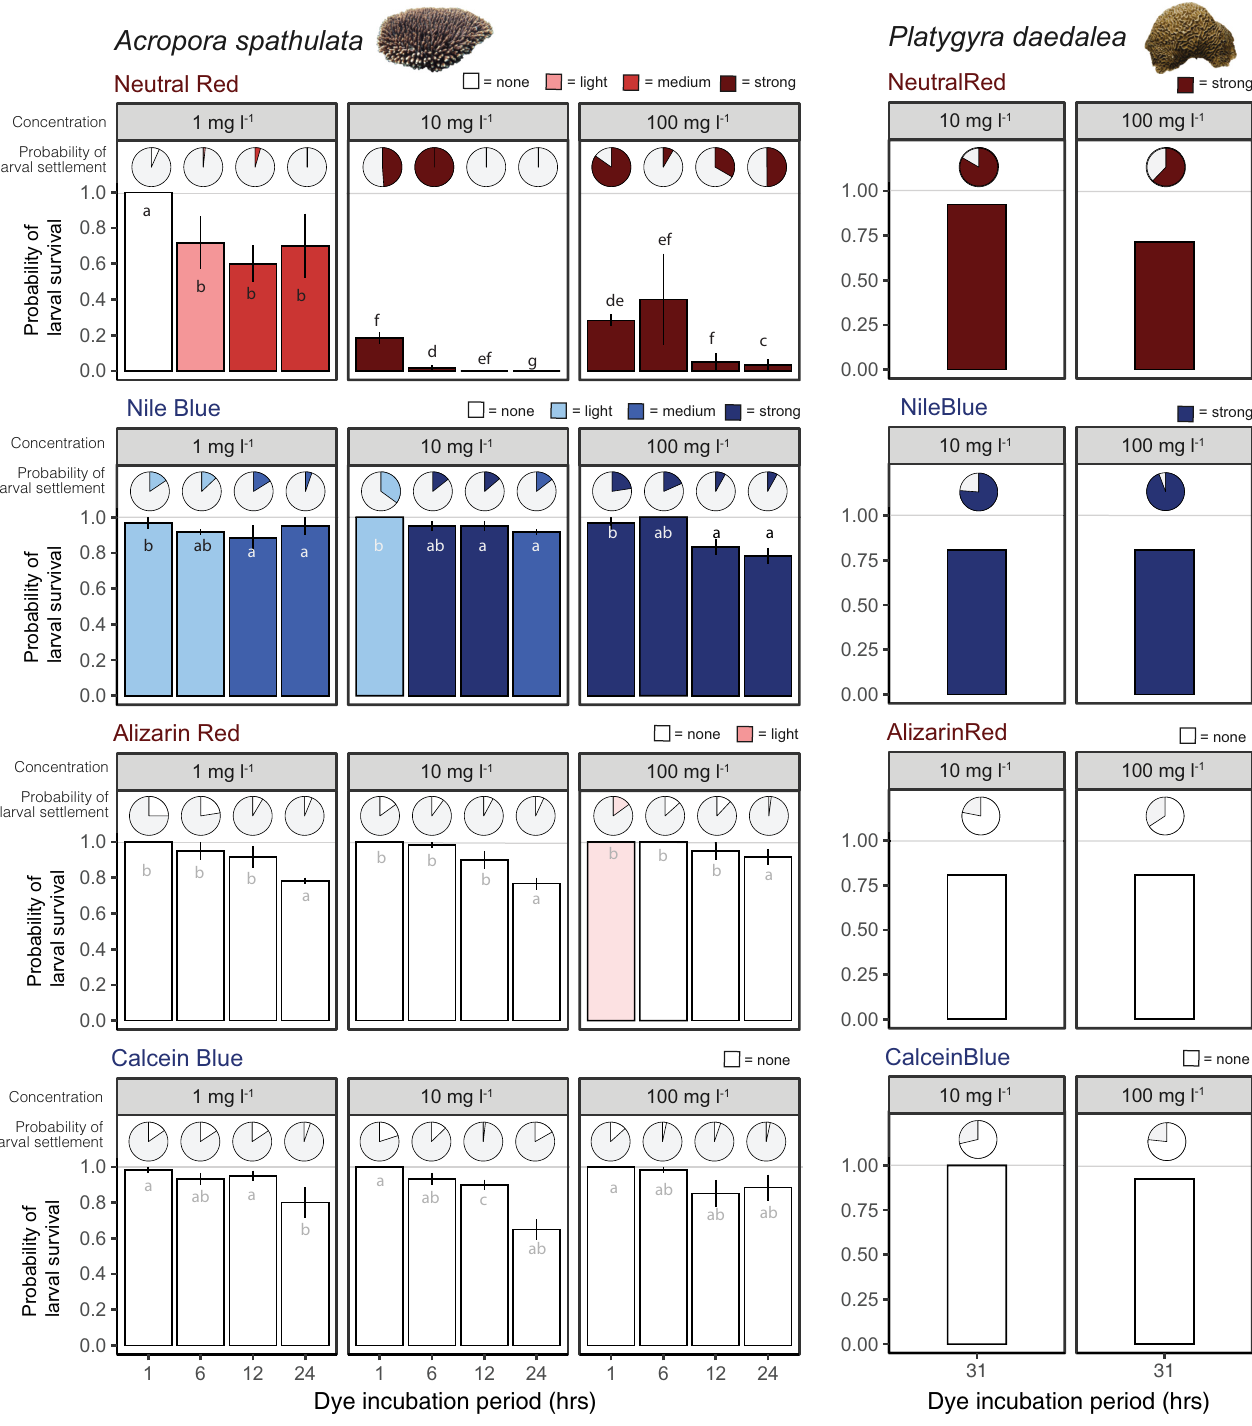
Fig 2. Probability of larval survival and settlement for two species of coral exposed to four stains at different concentration levels and incubation times. For probability of settlement, the filled proportion of the circle indicates the proportion of surviving larvae, and colors indicate the strength of the larval stain at each stage (larval stage and settled larvae; inset key indicates none, light, medium, or strong staining). Letters in bars indicate pairwise differences in probability of larval survival for A . spathulata . When a p value exceeds α = 0.05, then two means have at least one letter in common. Images supplied by authors. Data underlying this Figure can be found at